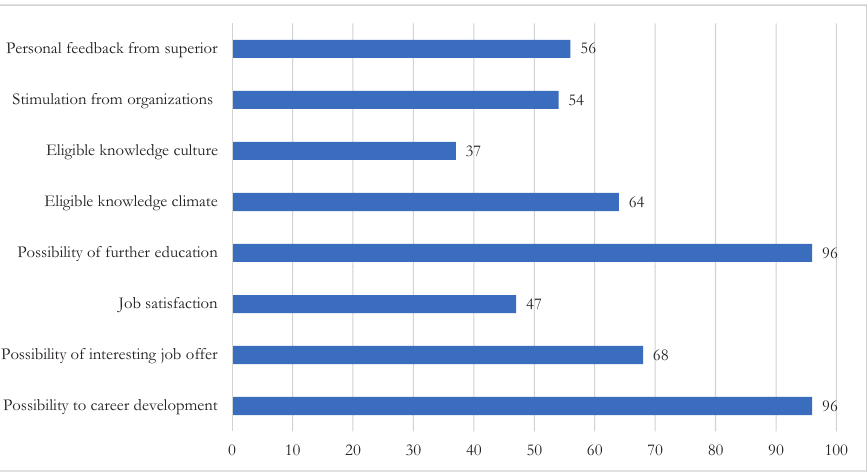
Fig. 3 – Employees perceive opportunities for development. Source: Own